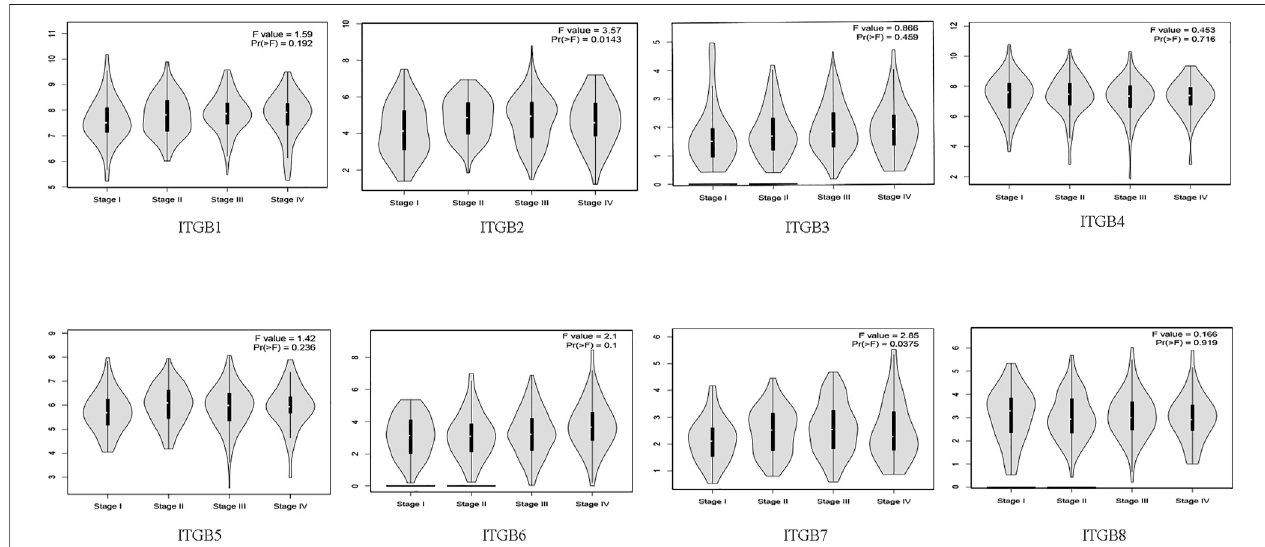
FIGURE 2 | Correlation between mRNA expression of ITGBs and tumor stages in patients with GC (GEPIA).